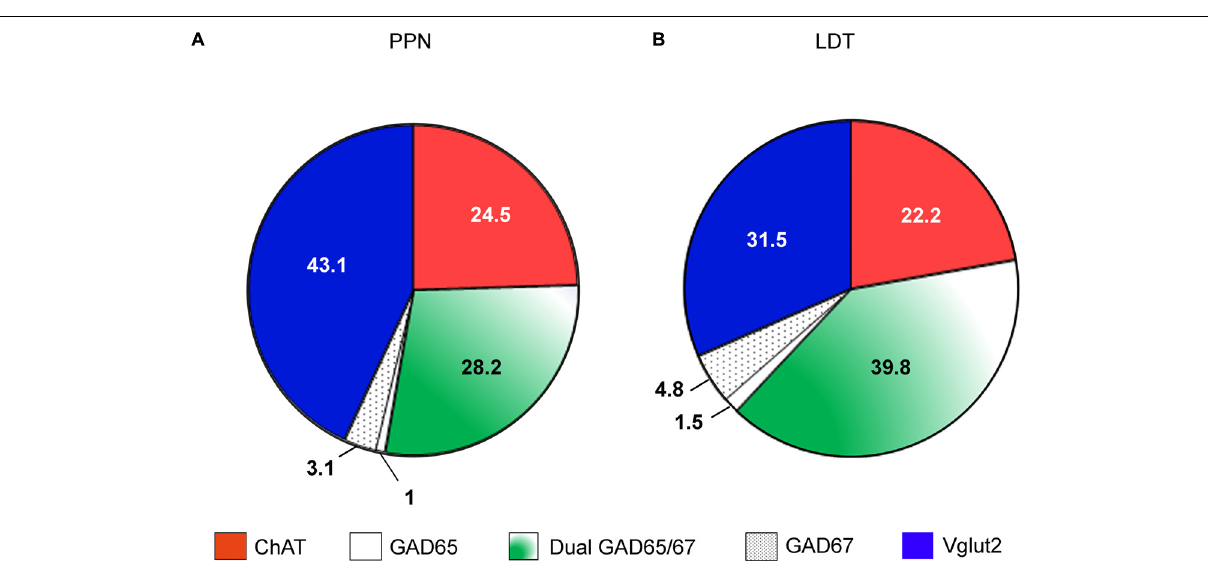
FIGURE 9 | Estimated cell composition of the PPN and LDT. Percentual estimations of the cell composition of both the PPN (A) and LDT (B) are presented as a summary of the data obtained in the present study. The largest subpopulation in the PPN is glutamatergic, while in the LDT, it is